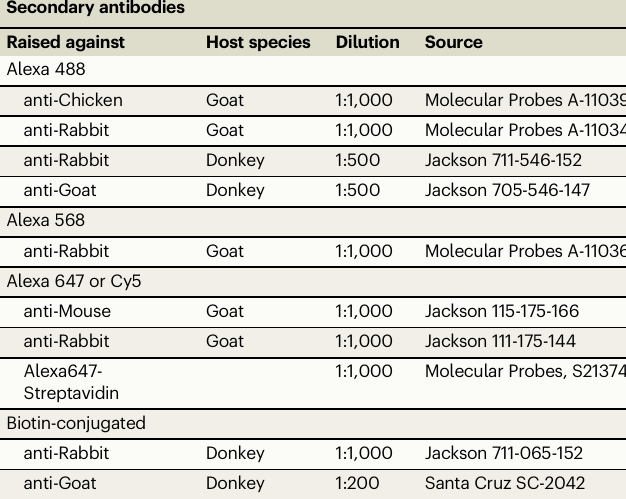
Table 3 | Details of the secondary antibody